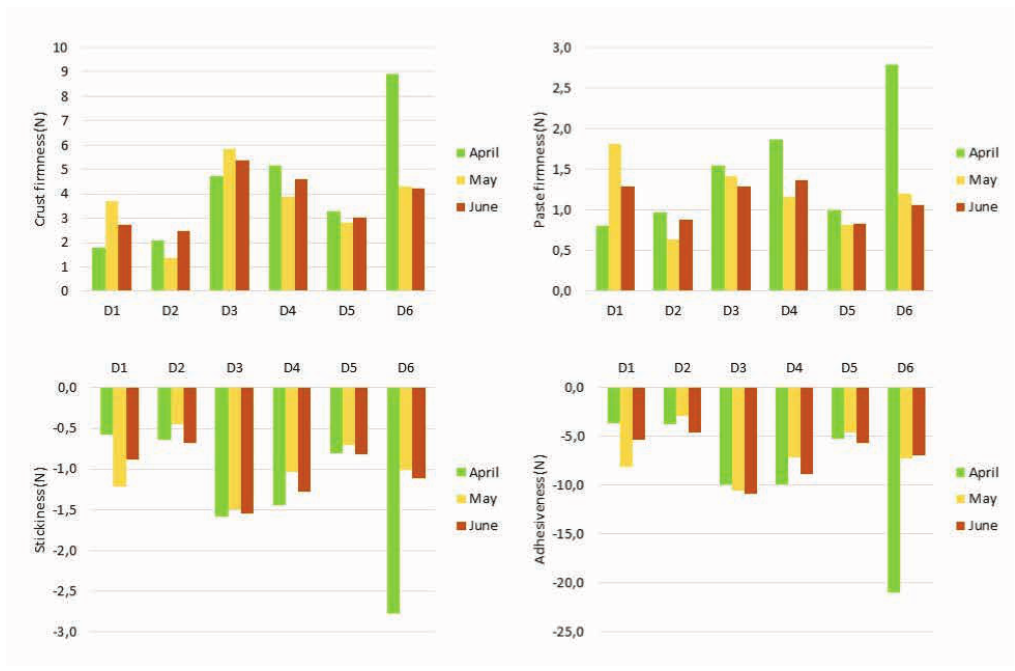
Figure 5: Variation of textural properties in the cheeses as a whole from April to June, obtained by the puncture test